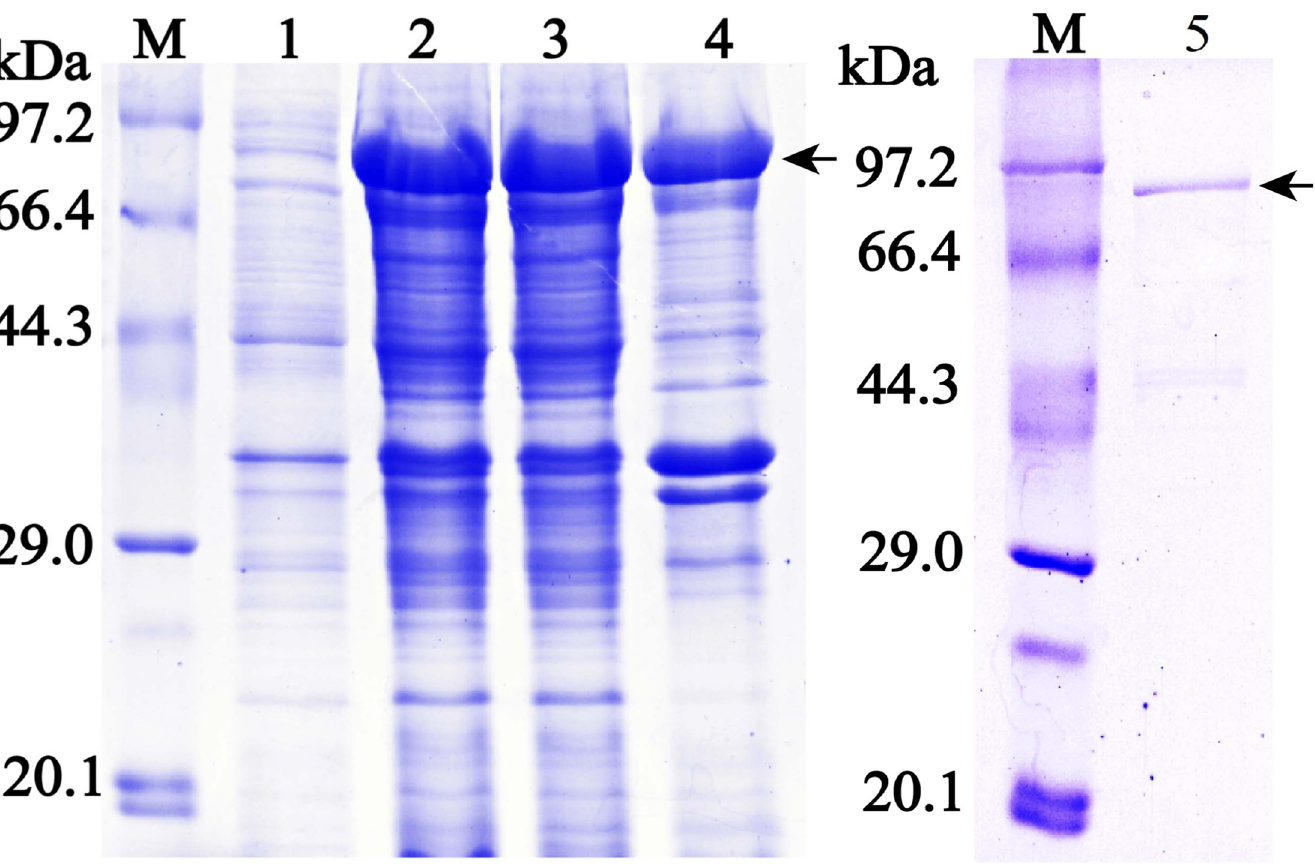
Fig 1. SDS-PAGE analysis of rTsASP2. M: protein marker; lane 1: lysates of recombinant bacteria incorporating pMAL-C2X/TsASP2 without induction; lane 2: lysates of recombinant bacteria incorporating pMAL-C2X/TsASP2 after induction; lane 3: lysate supernatant of recombinant bacteria incorporating pMAL-C2X/ TsASP2 after induction; lane 4: sediment of recombinant bacteria incorporating pMAL-C2X/TsASP2 after induction; lane 5: purified rTsASP2. The arrow represents the band of rTsASP2 (86.4 kDa).